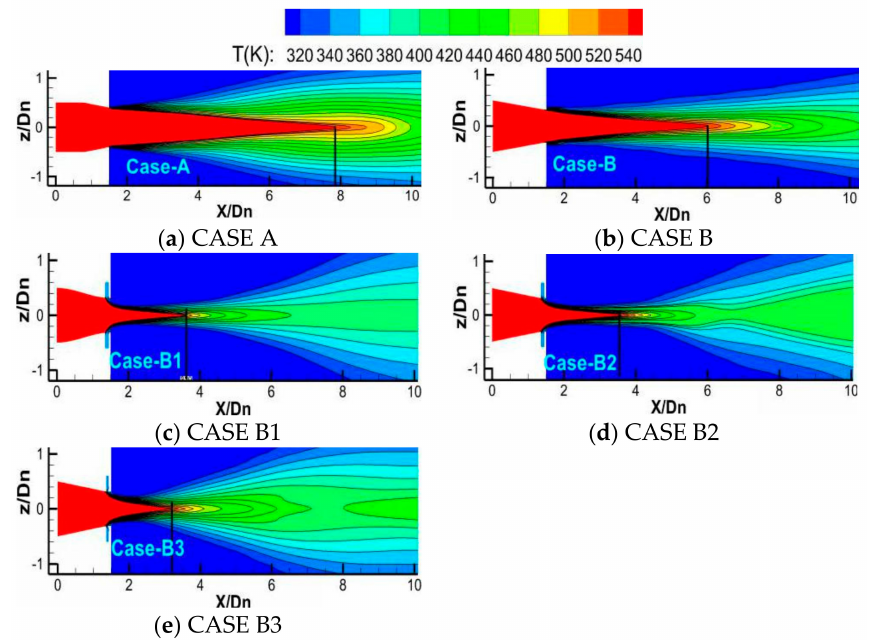
Figure 8. Temperature contour on the vertical plane. Figure 9a–e present the temperature distributions of the horizontal planes of CASE A–CASE B3. The results re obviously different from those of vertical planes. In Figure 9b, CASE B shows a contour profile of double peaks, which is different from that of CASE A. This observation shows that the mixing area was enlarged, and the mixing between the ambient and the hot jet was strengthened. This mixing led to a decrease in the high- temperature zone. The length of the high-temperature zone on the vertical and horizontal planes are marked with dotted and continuous lines, respectively. CASE B1 and CASE B2 also showed similar distributions, while CASE B3 showed a reduced high-temperature zone on both vertical and horizontal planes.